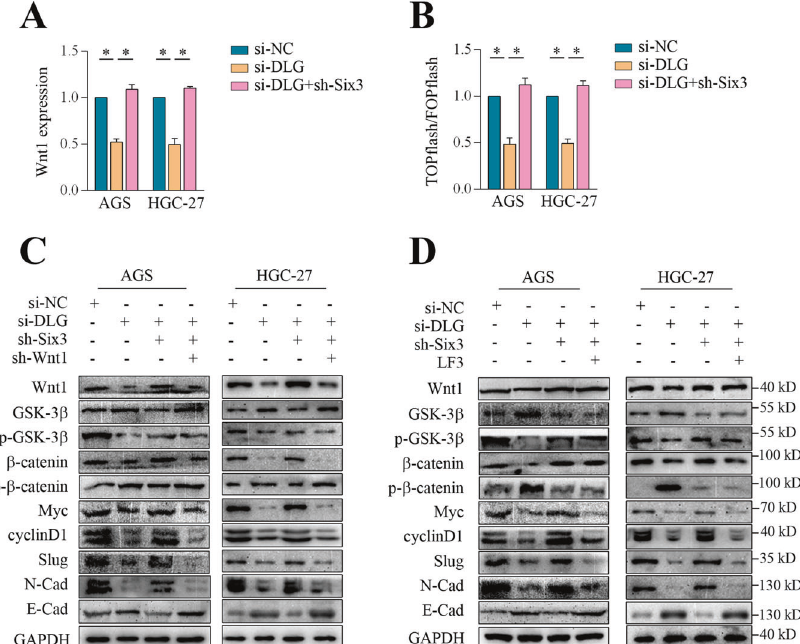
Fig. 5 Six3 and Wnt1 contributed to DLGAP1-AS2 mediated Wnt/ β -catenin signaling. A RT-qPCR analysis of Wnt1 expression in GC cells transfected with si-NC, si-DLGAP1-AS2, and si-DLGAP1-AS2 + sh-Six3. B TOP/FOP assays showing differential TCF/LEF activity between si-NC, si-DLGAP1-AS2, and si-DLGAP1-AS2 + sh-Six3 groups. C Western blot analysis of the main factors related to Wnt/ β -signaling upon transfection of si-NC, si-DLGAP1-AS2, si-DLGAP1-AS2 + sh-Six3, and si-DLGAP1-AS2 + sh-Six3 + sh-Wnt1. D Western blot analysis of the main factors related to Wnt/ β -signaling upon transfection/treatment with si-NC, si-DLGAP1-AS2, si-DLGAP1-AS2 + sh-Six3, and si-DLGAP1-AS2 + sh-Six3 + LF3. The data shown are representative of three independent experiments. * P <